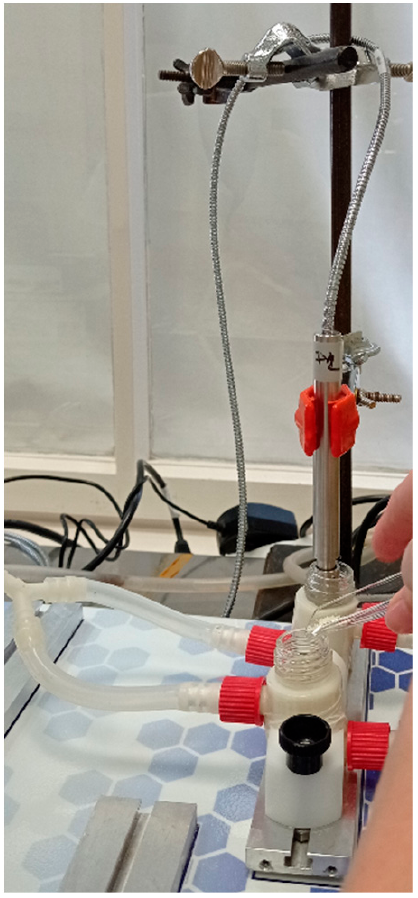
Figure 2. Modified horizontal diffusion model used for the in vitro and ex vivo permeability studies [33] .